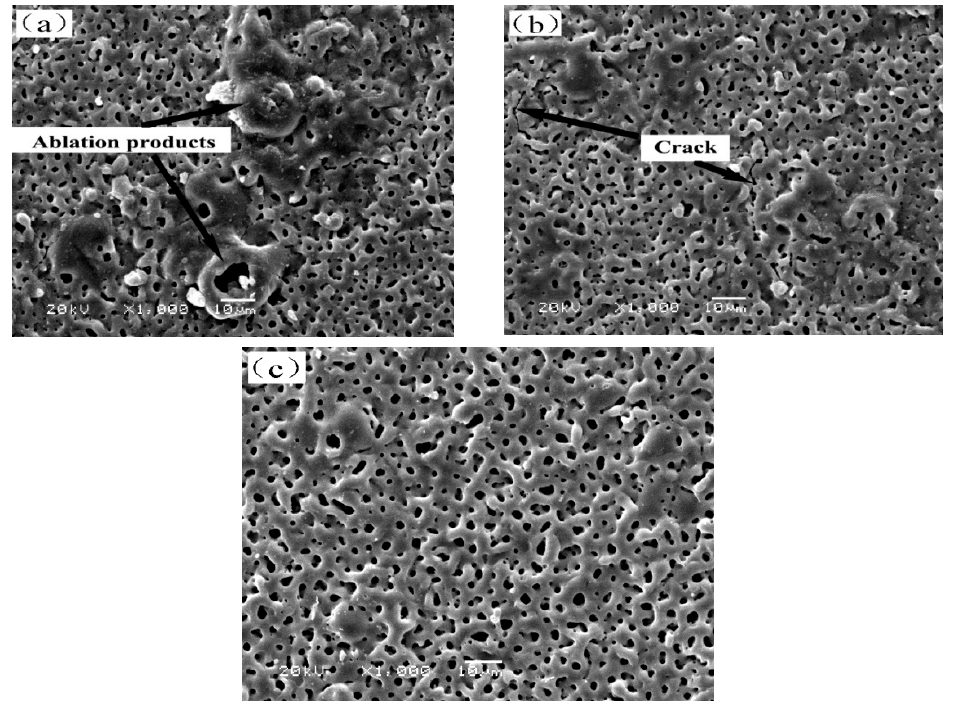
Figure 4. Surface morphology of MAO AZ91D Mg-alloy using pulsed direct current ( a ), pulsed bipolar current ( b ) and the pulsed with a discharge loop current ( c ) power supply mode.